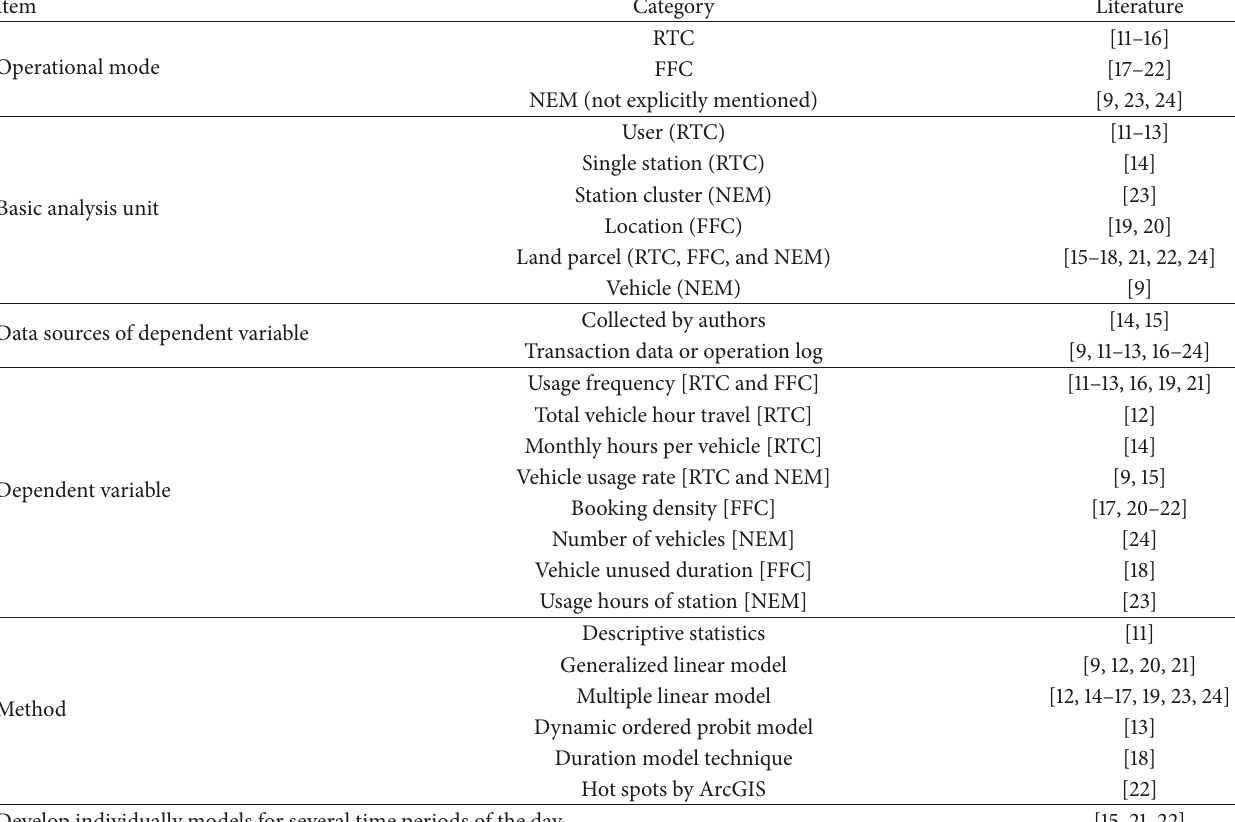
Table 1: Summary of document on identification of factors affecting demand